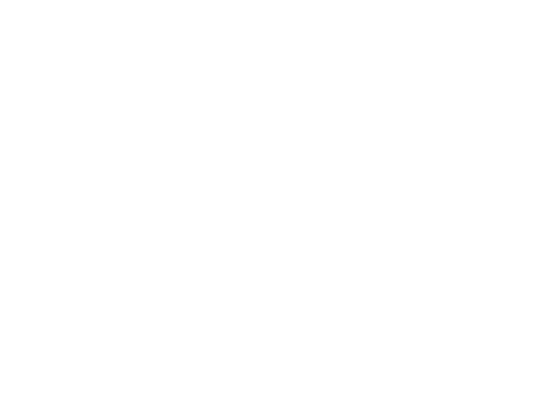
Figure 8. Meat consumption in Ukraine in 2020. The per capita figures are 26 kg for poultry, 19 kg for pork, 8 kg for beef and veal, and 1 kg for other meats